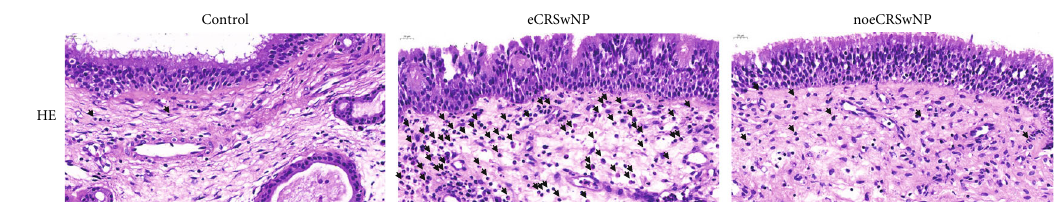
Figure 1: HE staining for nasal tissues of patients with eCRSwNP, noeCRSwNP, or control groups. The quantity of EOSs varied signi fi cantly between the eCRSwNP, noeCRSwNP, and control groups. EOSs: black